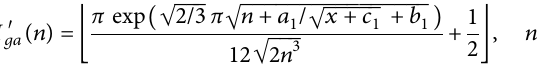
Figure 14: The graph of the function G